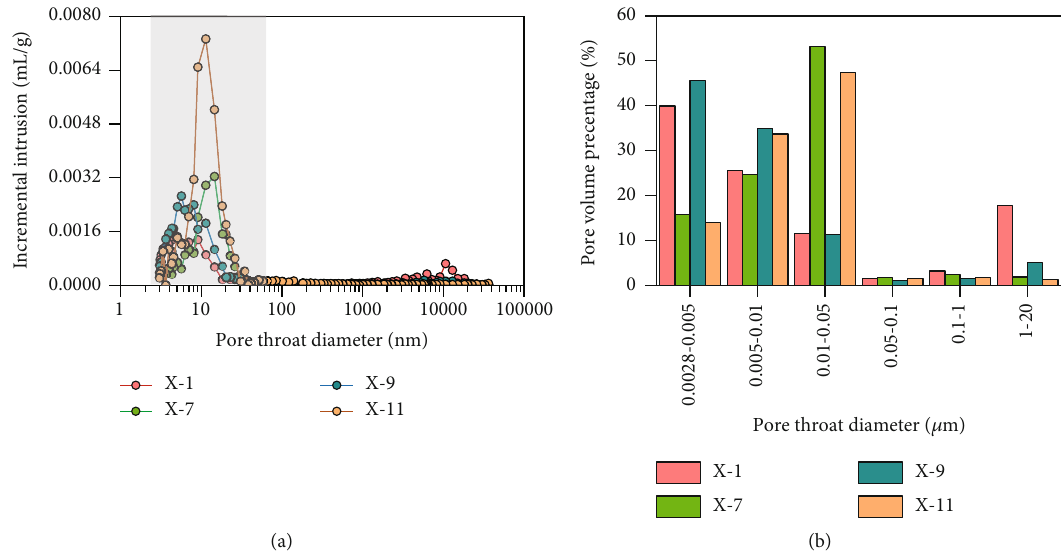
Figure 10: Pore-throat distribution curves as derived from MIP tests (a) and proportions of pore-throat sizes (b) in four samples with di ff erent